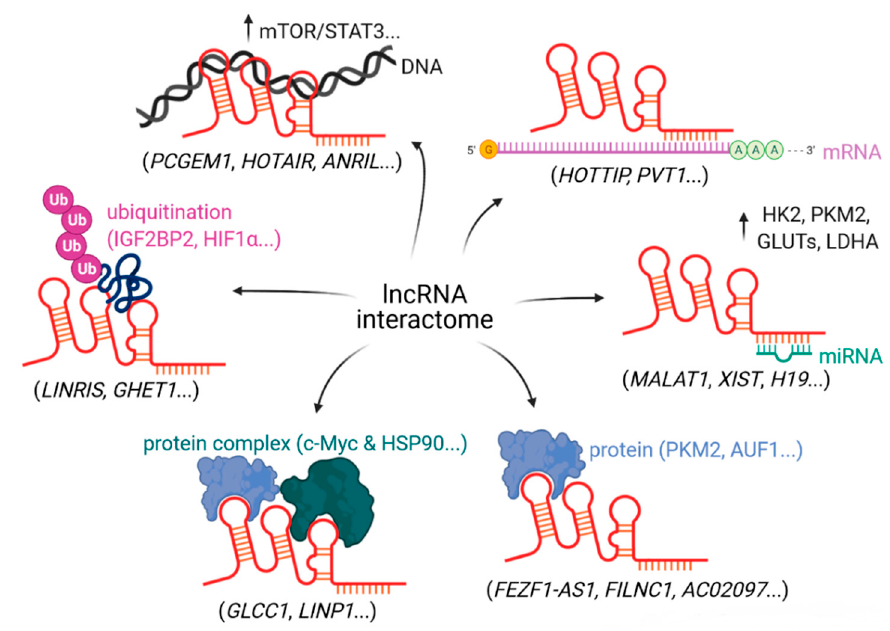
Figure 1. Schematic representation of a long non-coding RNA (lncRNA) interactome. LncRNAs interact with various molecules to perform important cellular functions (created with BioRender).